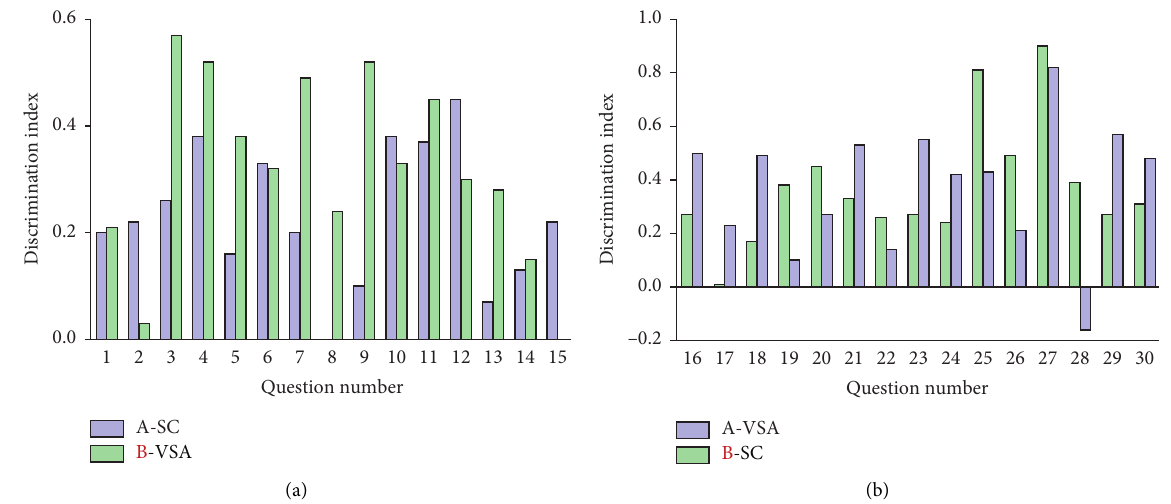
Figure 5: Comparison of discrimination indices of SC versus VSA questions for questions #1–15 (a) and for questions #16–30